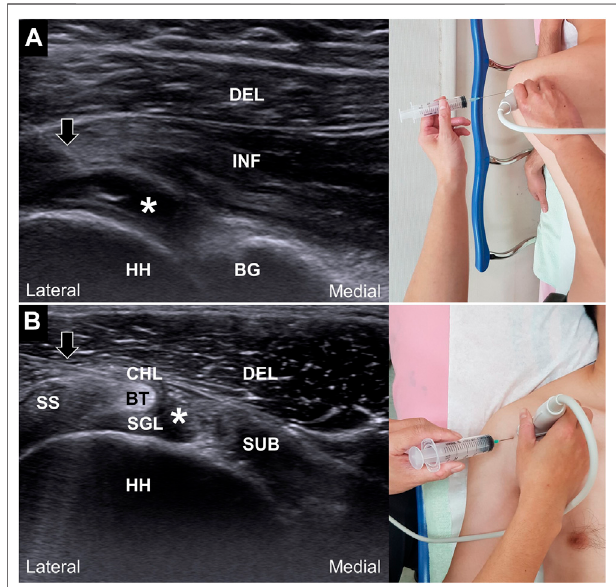
FIGURE 1 | Ultrasound guided hydrodilatation through the posterior glenohumeral recess (A) and rotator cuff interval (B) . Black arrows: needles; white asterisks: injectate; DEL: deltoid muscle; INF, infraspinatus muscle; HH, humeral head; BG, bony glenoid of the scapulae; SS, supraspinatus tendon; SUB, subscapularis tendon; CHL, coracohumeral ligament; BT, long head of the biceps tendon; SGL, superior glenohumeral